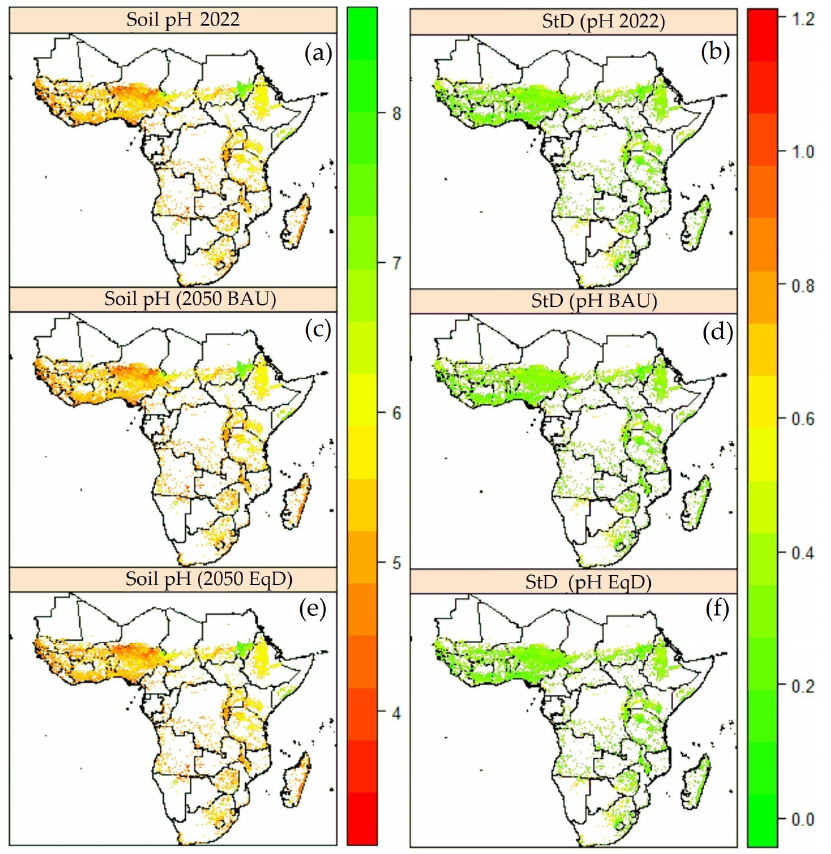
Figure 7. Current and predicted soil pH variations in the different scenarios and their uncertainties. ( a ) Current soil pH map for 2022, and ( b ) its uncertainties as a standard deviation map (pH units). ( c ) Predicted soil pH map for 2050 in the BAU scenario, and ( c ) its uncertainties as a standard deviation map. ( d ) Predicted soil pH map for 2050 in the EqD scenario, ( e ) Predicted soil pH map in the EqD scenario and ( f ) its uncertainties as a standard deviation map. See Figure S5 for all scenario maps for soil pH. Remote Sens. 2023 , 15 , x FOR PEER REVIEW Ensemble machine learning (RF and xgbDART) increased model performance by re- ducing model errors (RMSE and MAE) and increasing the R 2 for the soil pH decline model. The density scatter plots of the predicted against the observed soil pH decline showed that the observed and predicted points were concentrated along the 1:1 line and that the prediction errors were low (Figure 8a–c). The errors (RMSEs) of the soil pH decline pre- diction ranged from 0.02 to 0.07 pH units (1980–2050) and the R 2 ranged from 0.88 to 0.91.